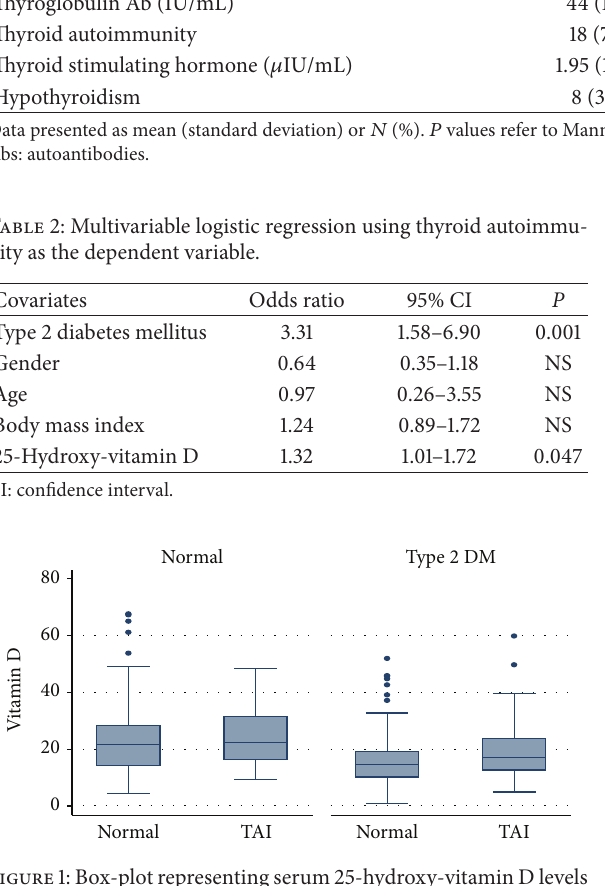
Figure 1: Box-plot representing serum 25-hydroxy-vitamin D levels by study group and thyroid autoimmunity